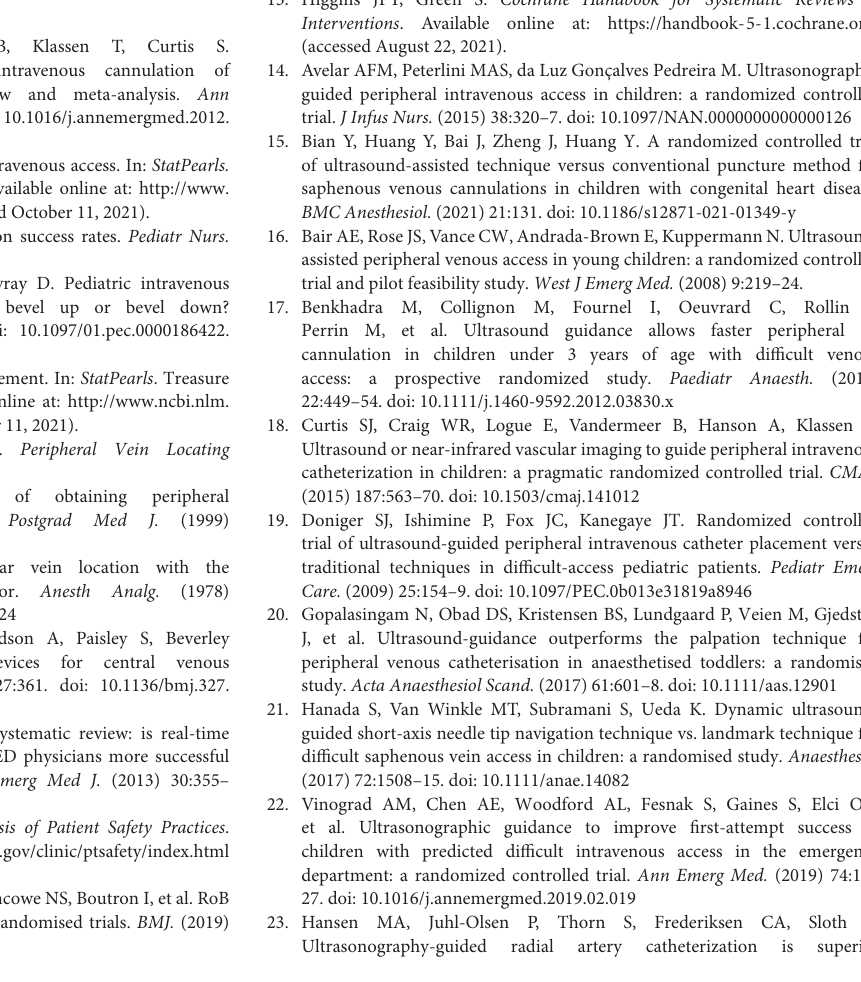
Supplementary Figure 1 | Sensitivity analysis for first attempt success rate. Supplementary Figure 2 | Sensitivity analysis for overall success rate. Supplementary Figure 3 | Sensitivity analysis for number of attempts before successful cannulation. Supplementary Figure 4 | Sensitivity analysis for time taken before successful cannulation. Supplementary Figure 5 | Sensitivity analysis for number of needle